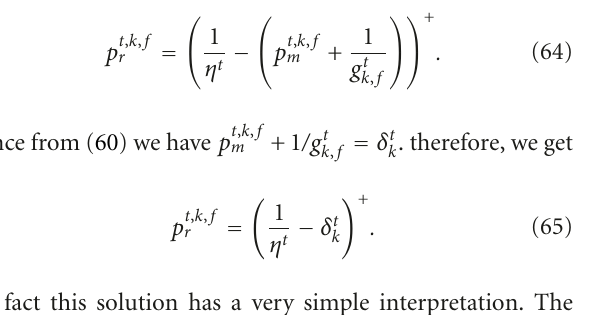
Figure 2: Illustration of multiuser waterfilling for 2 user 8 subcarrier system for feasible